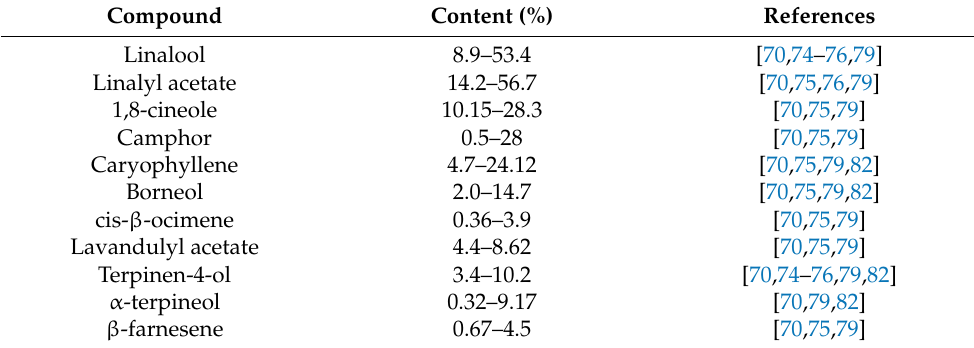
Table 4. The main compounds of the oil distilled from the L. angustifolia